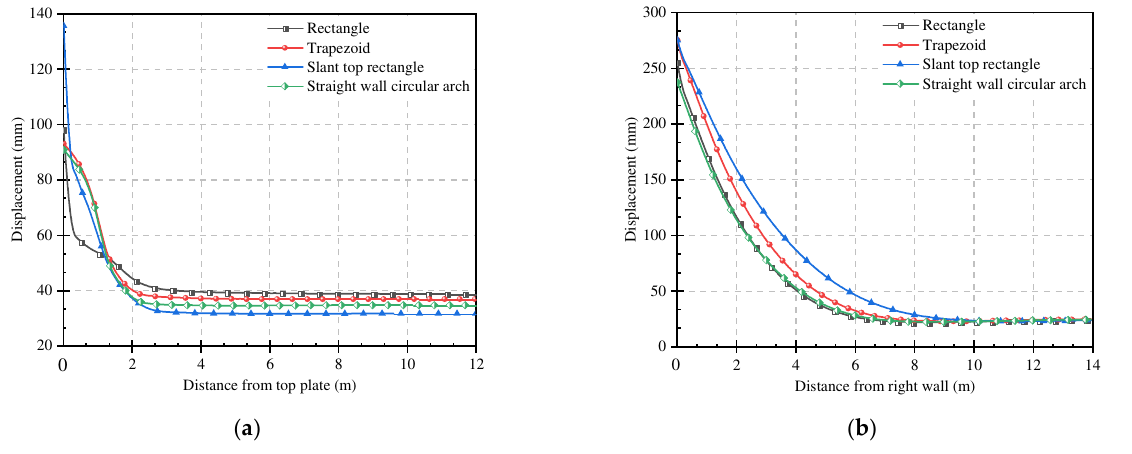
Figure 13. Displacement evolution curves of surrounding rock in different roadway section forms: ( a ) displacement evolution law of top slab; ( b ) displacement evolution law of right gang. Figure 13a reflects the displacement distribution of the top plate in different sections.